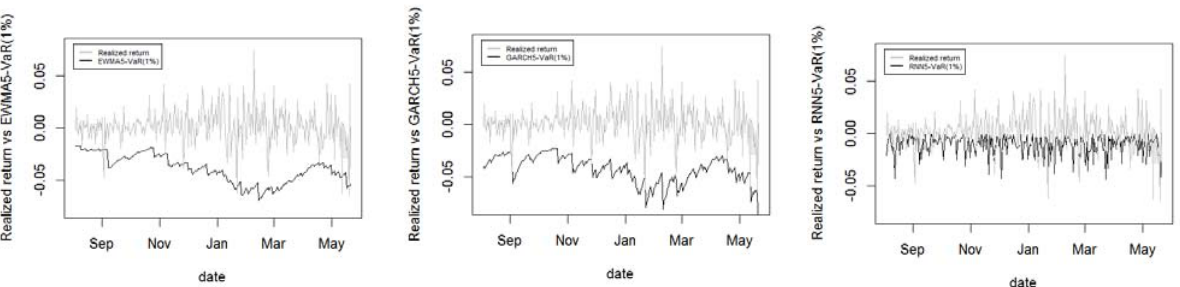
volatility forecasting of EWMA, GARCH and RNN model.